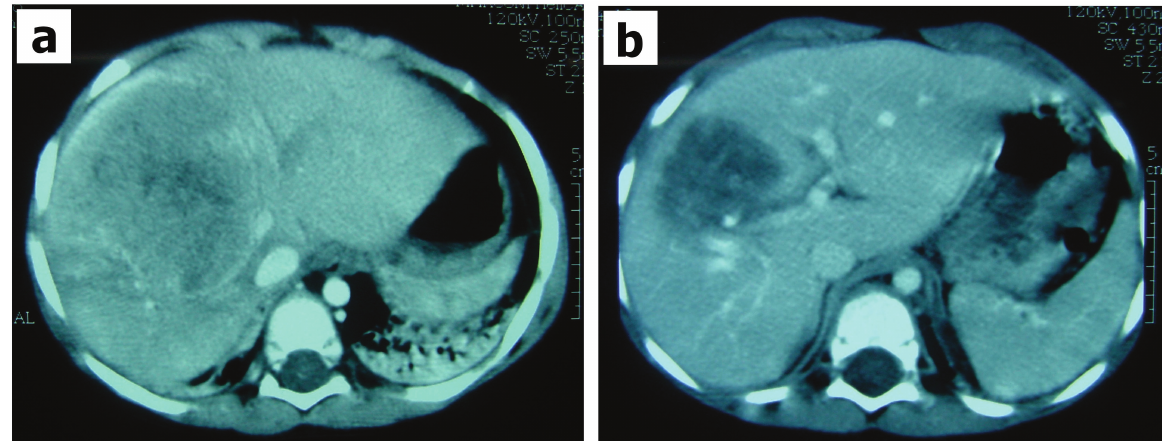
Figure 2 - CT scan of a patient with hepatoblastoma in the right hepatic lobe before (a) and after (b) chemotherapy. The tumor size decreased, and the patient underwent right hepatectomy with surgical margins that were free of tumor